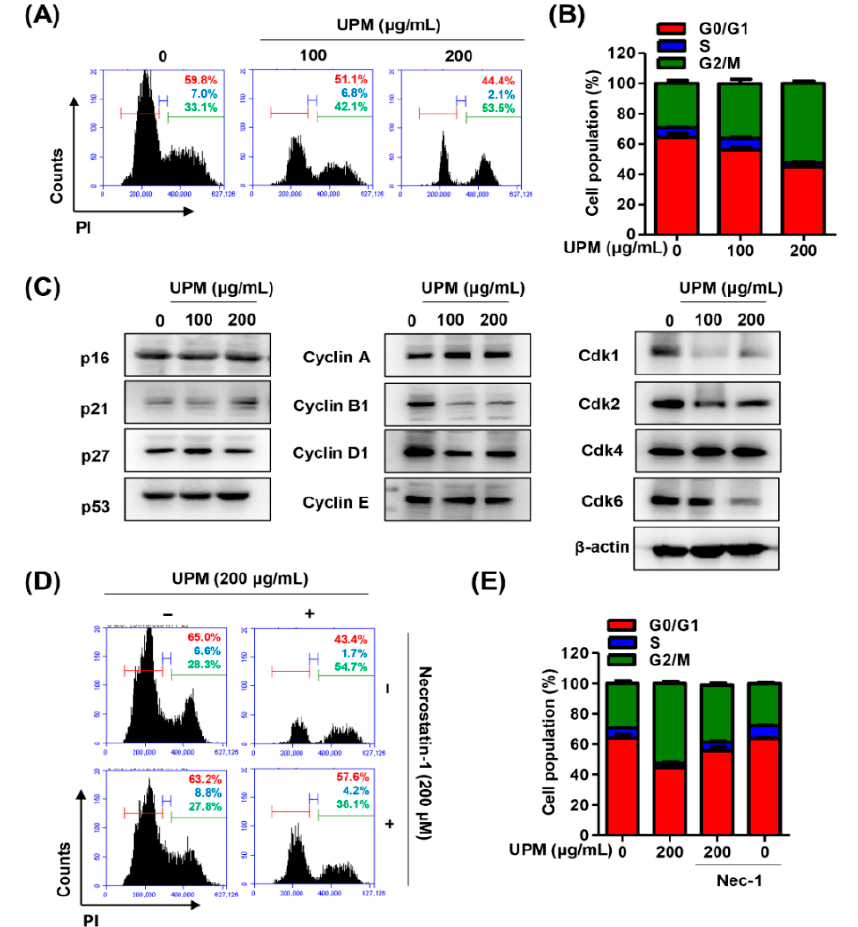
Figure 3. UPM mediates G2/M cell cycle arrest in ARPE-19 cells. ( A ) The representative histograms of ARPE-19 cells incubated with PI for flow cytometry analysis. ( B ) The average percentages of ARPE-19 cells incubated with PI in each phase of the cell, except for the cells at the sub-G1 phase. ( C ) The expression of cell cycle-regulatory proteins. ( D ) The representative histograms of ARPE-19 cells pretreated with 200 µ M necrostatin-1 for 1 h and then treated with 200 µ g/mL UPM for 24 h. The cells were stained with PI. ( E ) The average percentages of ARPE-19 cells pretreated with 200 µ M necrostatin-1 for 1 h and treated with 200 µ g/mL UPM for 24 h in each phase of the cell cycle, except for the cells at the sub-G1 phase.